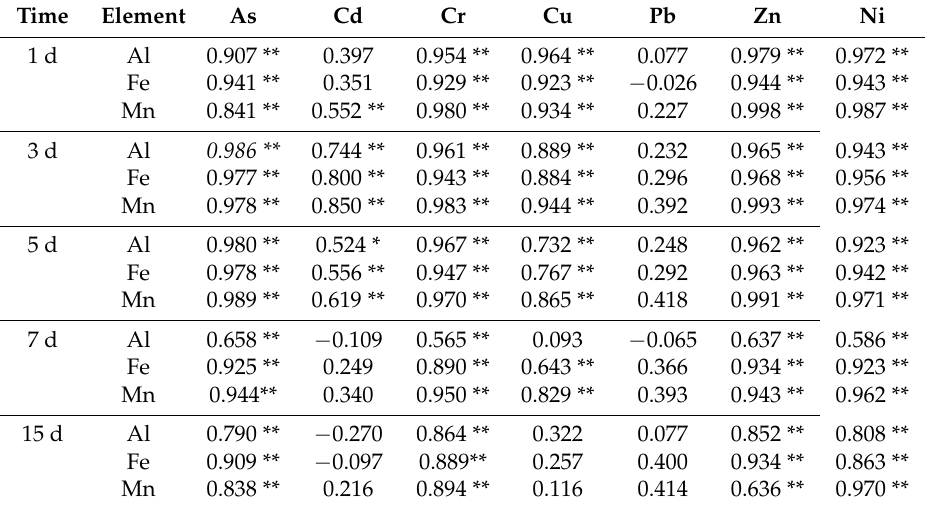
Table 6. Correlation coefficient between each selected trace metal and each of other elements investigated in this study ( n =